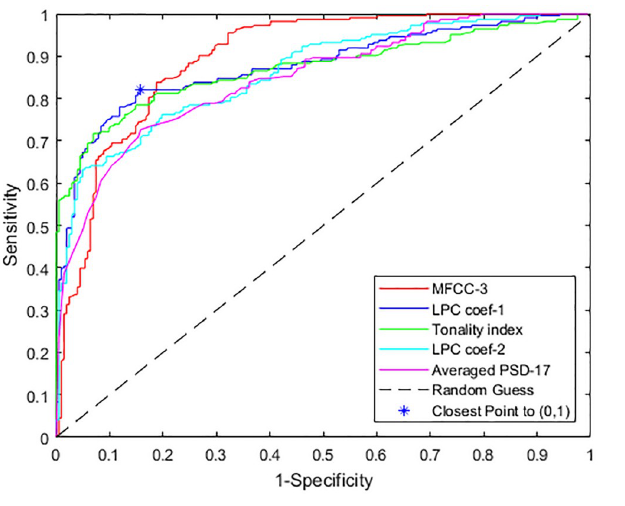
Fig 4. ROC of features with the highest